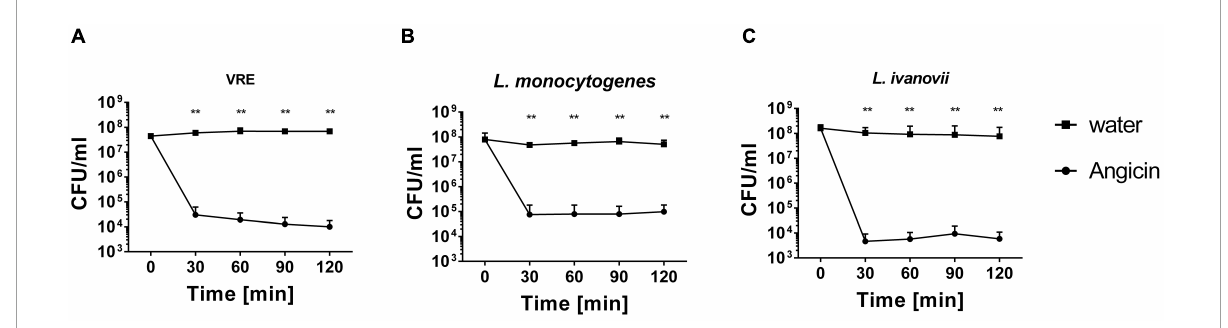
FIGURE1 Survival of vancomycin resistant Enterococcus faecium (VRE) (A) , Listeria monocytogenes (B) and Listeria ivanovii (C) in the presence of Angicin. Bacteria were incubated with or without 1.56 µ g/ml Angicin in 10 mM Phosphate buffer for 2 h. After 30, 60, 90, and 120 min, samples were taken and colony forming units (CFU) per ml were determined. To determined the amount of bacteria in the solution, a sample of the water control was used. Depicted is the mean + standard deviation of 5 independent experiments. Significant differences were calculated using a Mann-Whitney- U -test. **Illustrates a p -value <